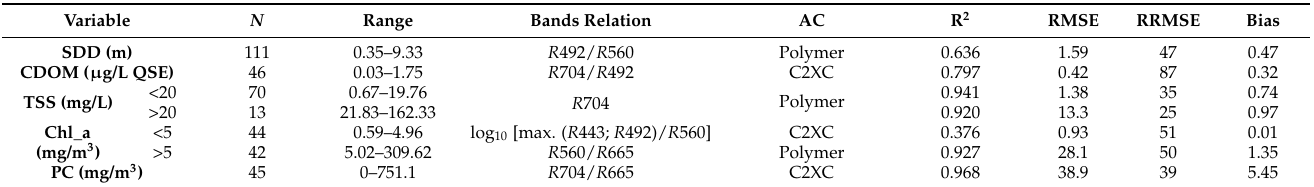
Table 5. Best validation results for in situ spectrometry waters quality algorithms and AC